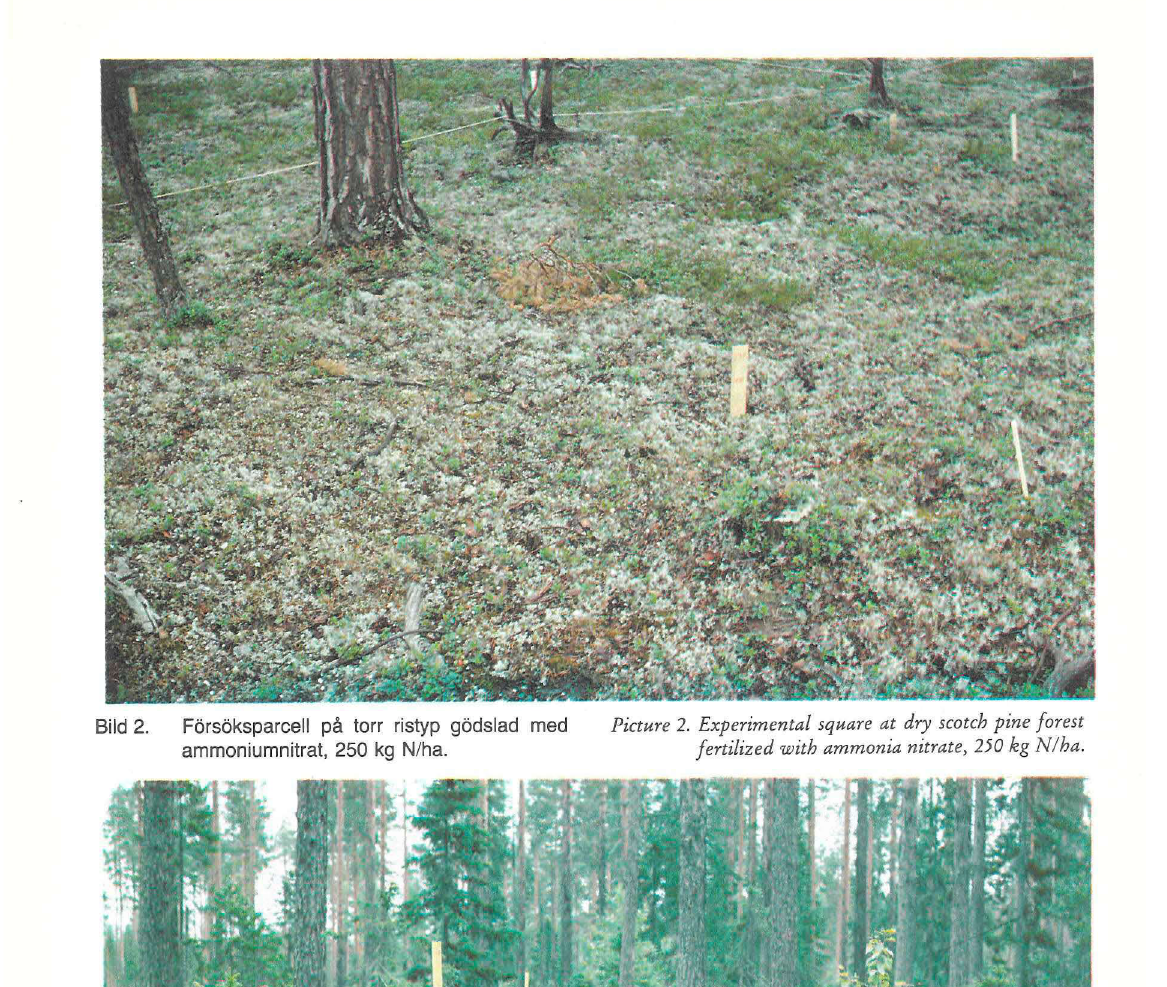
Picture 2. Experimental square at dry scotch pine forest ammoniumnitrat, 250 kg N/ha. fertilized with ammonia nitrate, 250 kg